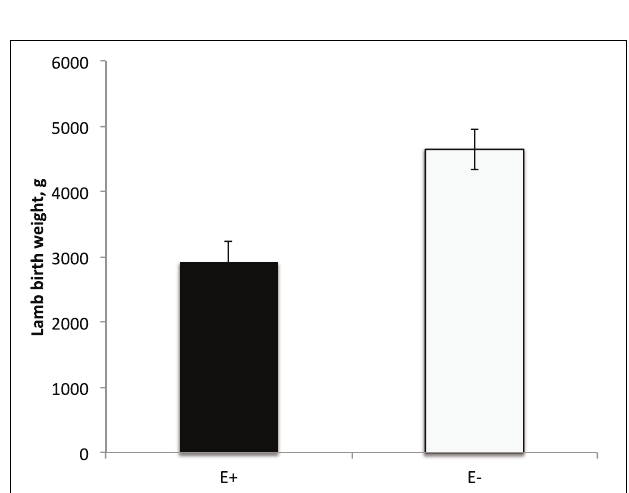
FIGURE 3 | Lamb birth weight from ewes fed tall fescue seed with endophytes (E + ) vs. endophyte-free (E − ) during gestation. Treatment was significant ( P =